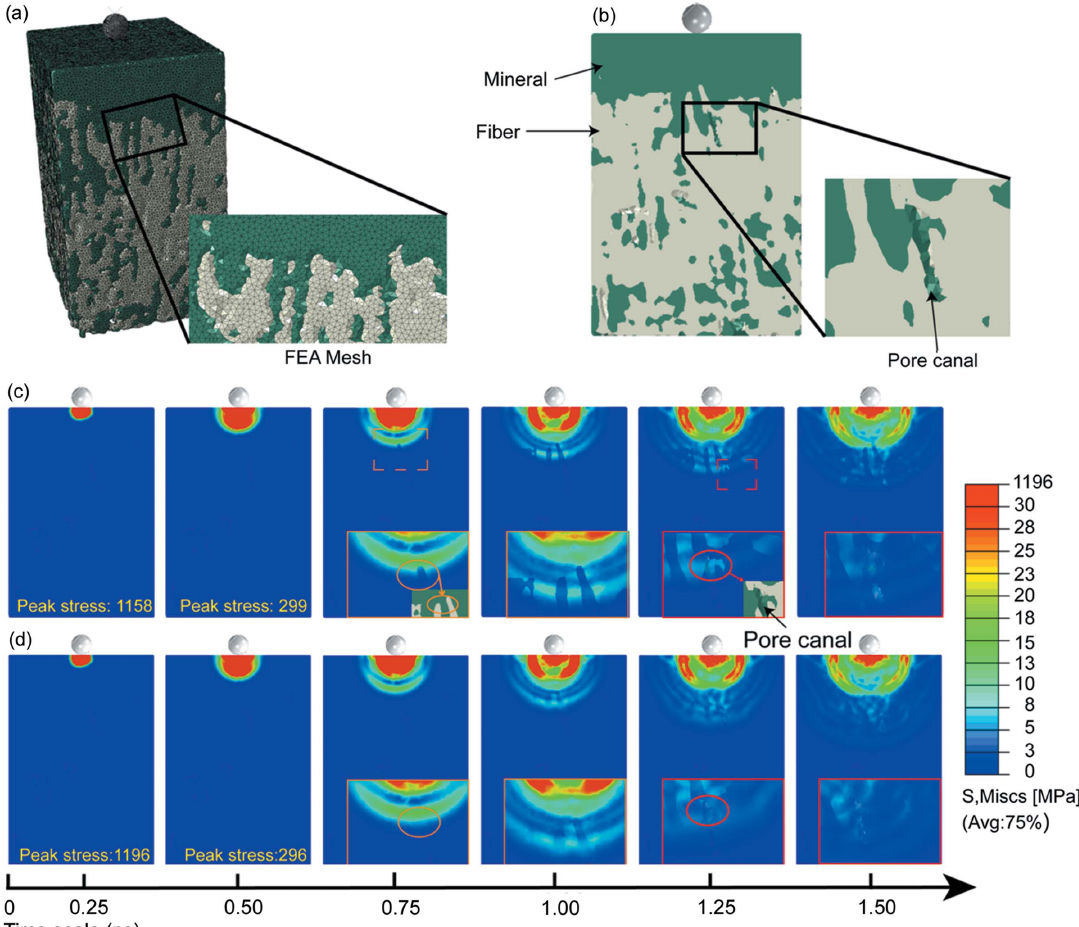
Figure 6 DFEM simulation for structure and mechanical analysis of the impact surface and impact region. ( a ) 3D schematic of our model following the complex microscale geometry of the impact surface and impact region. Color-coding corresponds to the different components. As shown in ( b ), the interlocking structural design of mineral particles and fiber bundles as well as the distribution mineral coated pore canals were fidelity retained in our model. Panels ( c ) and ( d ) correspond to the average von Mises stress distribution cloud diagrams of models with ( c ) mismatch and ( d ) uniform elastic modulus, respectively. The peak von Mises stress can be found in the bottom right corner of certain